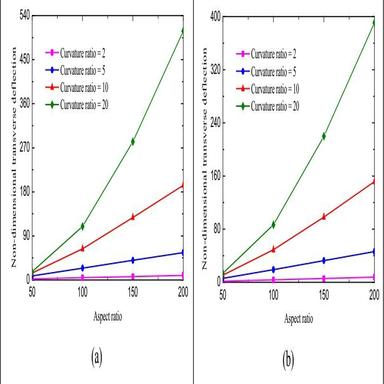
Non-dimensional deflection of a graphene reinforced GFRP panel under CFCF end conditions. (a) UVL (b) SSL.